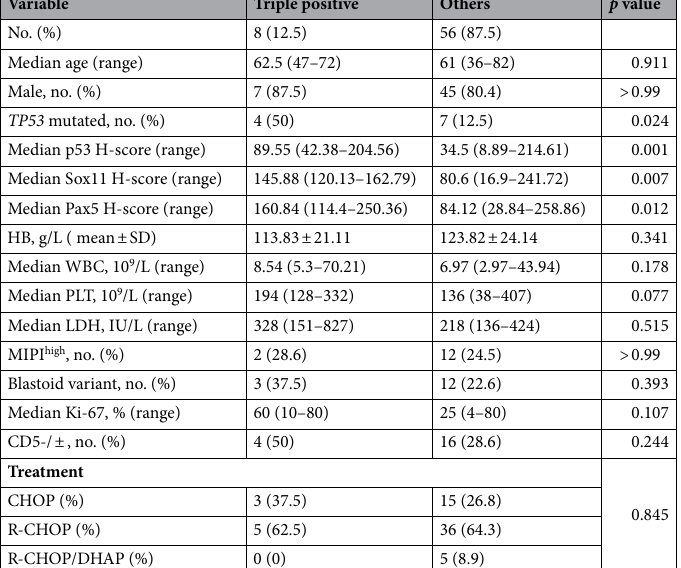
Table 3. Comparison of triple-positive patients with the other patients.